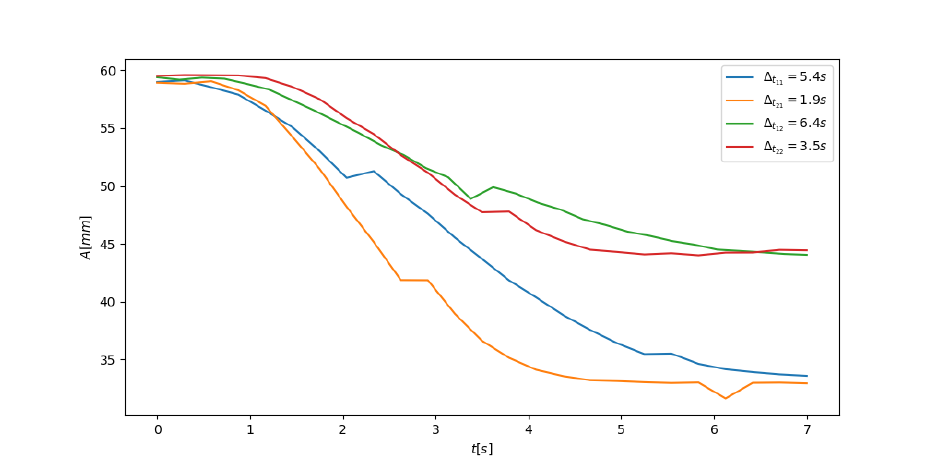
Figure 14. Envelopes of recorded waveforms for various operating parameters.